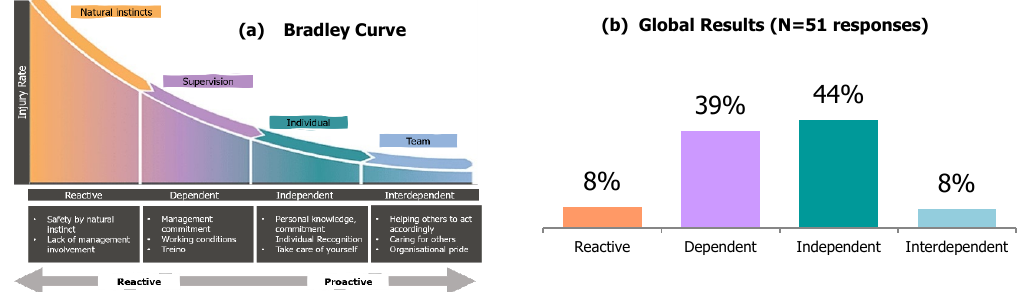
Figure 6 . (a) Bradley Curve and (b) data obtained on the robustness of current OHS practices and systems in case study C